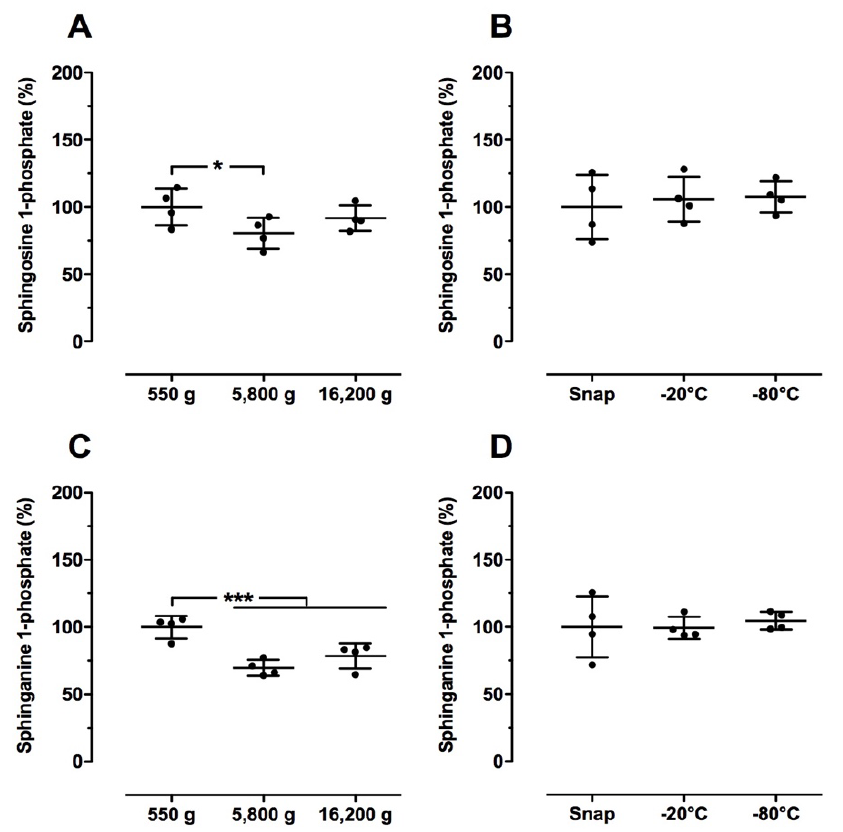
Figure 4. Effect of sample preparation on relative sphingosine 1-phosphate ( A , B ) and sphinganine 1-phosphate ( C , D ) levels in human blood samples. ( A , C ) Plasma was directly separated from blood (EDTA as anticoagulant) by 5 min centrifugation (4 °C) at 550× g , 5800× g or 16,200× g . ( B , D ) Plasma was directly separated from blood (EDTA as anticoagulant) as described in the Material and Methods section. Thereafter, plasma samples were either snap frozen in liquid nitrogen or frozen at − 20 °C or − 80 °C. Plasma separated at 550× g ( A , C ) and snap frozen ( B , D ) served as the respective controls (100%). All plasma samples were stored at − 80 °C until LC-MS/MS analysis. Data are shown as mean (in %) ± SD ( n = 4). * p < 0.05, *** p < 0.001. Table 6. Effect of sample preparation on relative sphingolipid levels in human blood samples.